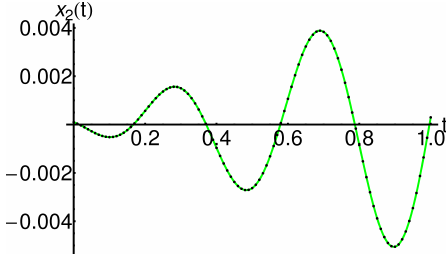
Fig. 2. Comparison between the approximate solutions ¯ x 2 given by Eq. (29) and the corresponding numerical